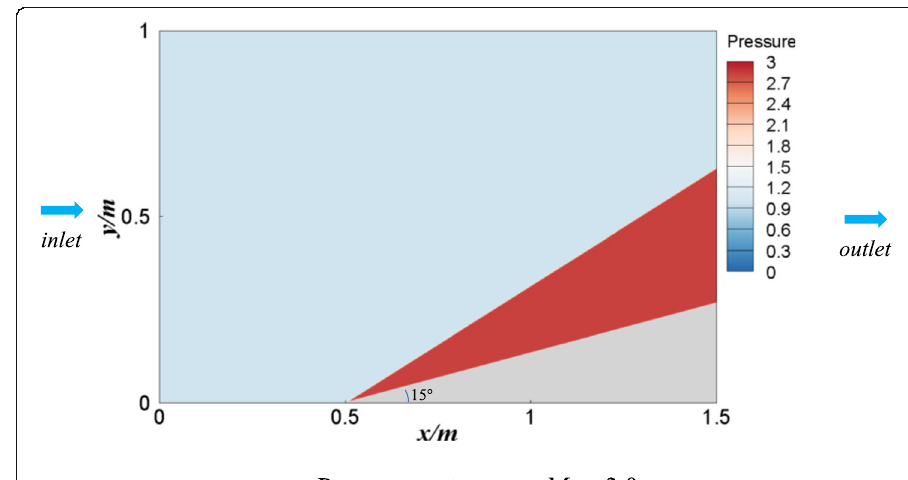
Fig. 3 Pressure contours at Ma = 3.0